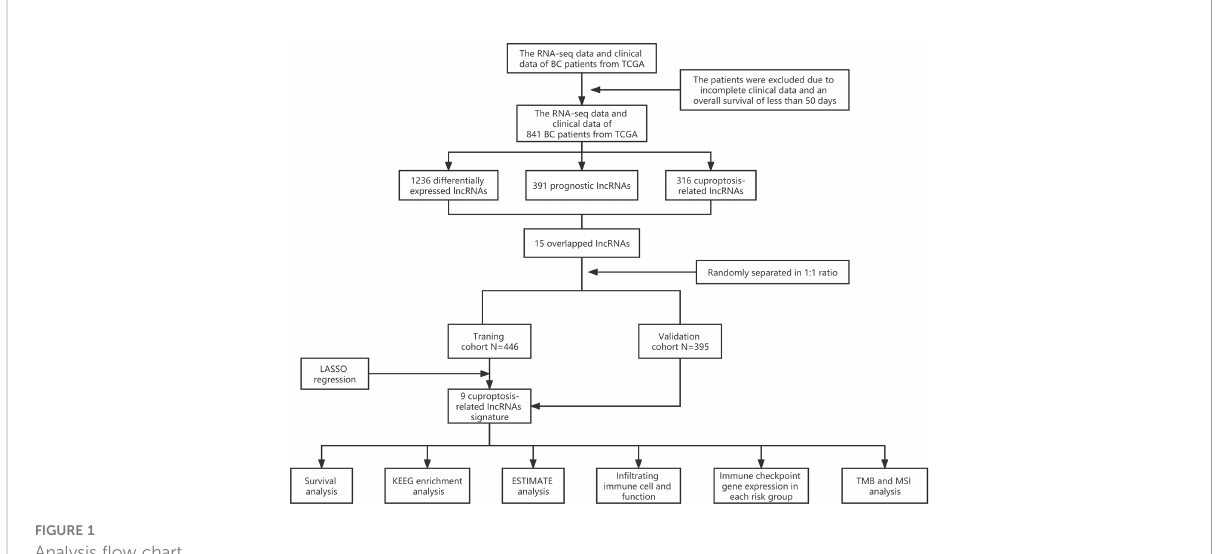
FIGURE 1 Analysis fl ow